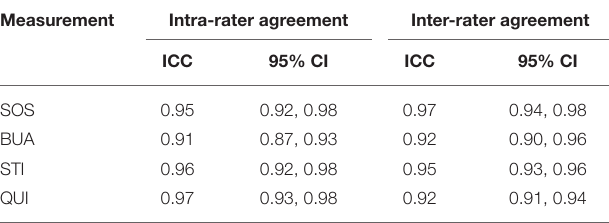
TABLE 2 | Reliability of quantitative ultrasound measurements. Measurement